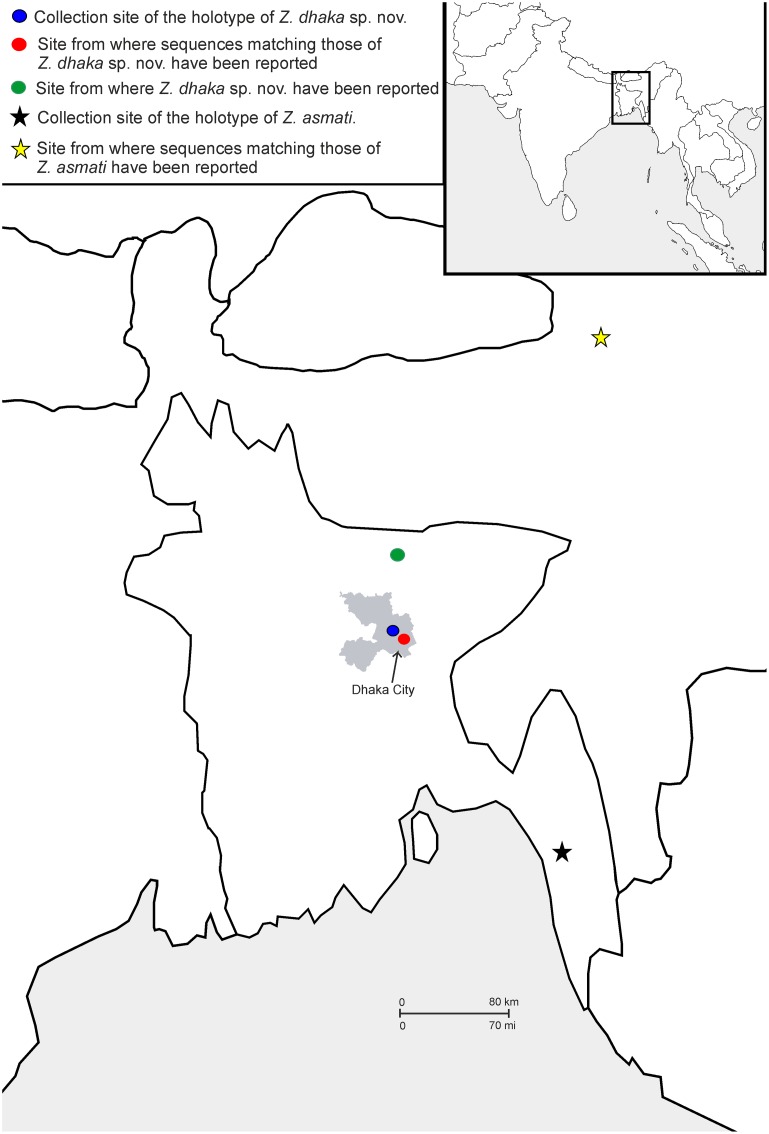
Maps showing the type locality for Zakerana dhaka sp. nov. found from Sher-e-Bangla Agricultural University campus, Sher-e-Bangla Nagar, Dhaka, Bangladesh (blue dot).The map also shows the other locality from where the new species was encountered within Dhaka, as well as the location from where individuals with the same haplotype have been encountered (see text for details). The type locality of Zakerana asmati, a species closely related to Z. dhaka, is indicated on the map with black star. The approximate borders of the urban core of Dhaka city are delineated in grey.